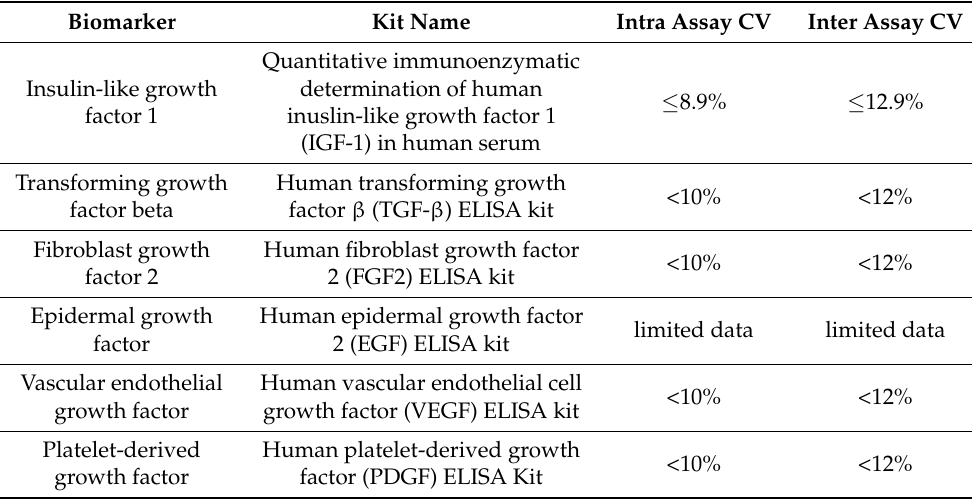
Table 1. Intra- and inter-assay coefficients of variability.